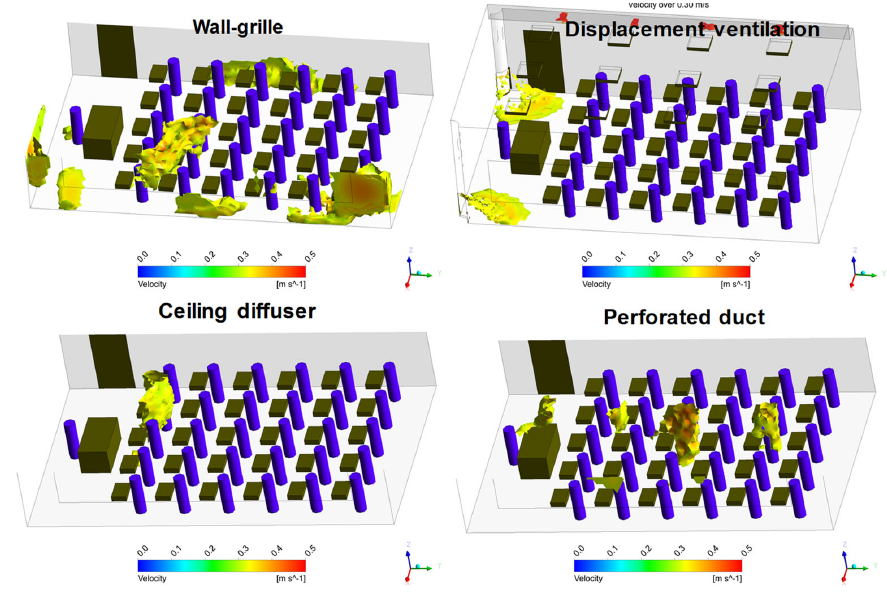
Figure 12. Air velocity distribution in summer. In winter, the air velocity in the occupied zone is both quite low with the displace ‐ ment terminal unit and ceiling diffuser. The air velocity is higher at the window side with the wall ‐ grille and some parts of the occupied zone with the perforated duct.